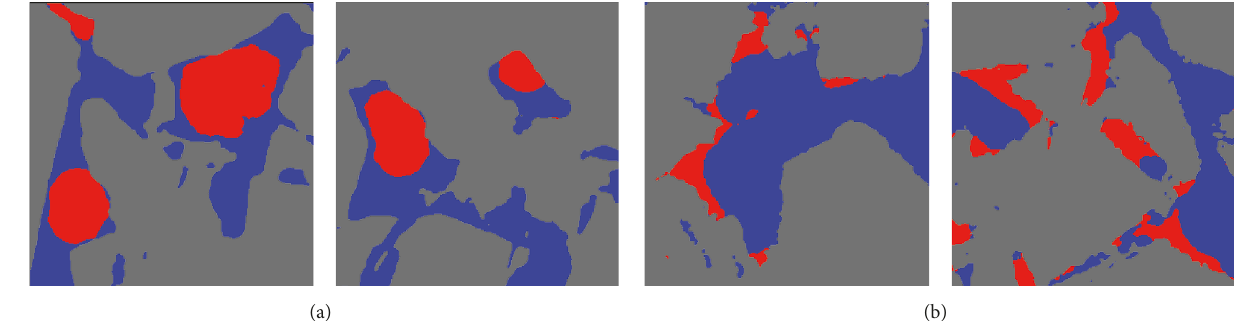
Figure 14: The morphology and distribution of oil-water phase interfaces in water-wet plug (a) and oil-wet plug (b) at the end of 1-PV water flooding.